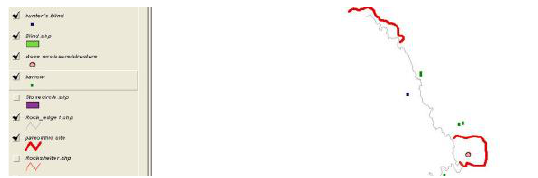
Figure 11. Recording Paleolithic abri sites and hunters’ blinds at Tar al-Sbai using a tachaeometre. Measurements by M. Saario and Donald Lillqvist 2000, computer mapping by J. Okkonen.